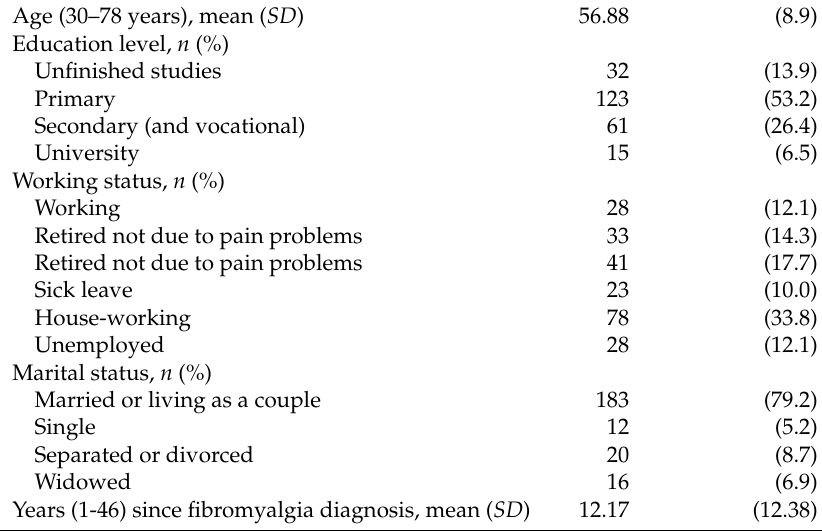
Table 1. Sociodemographic characteristics of the participants.